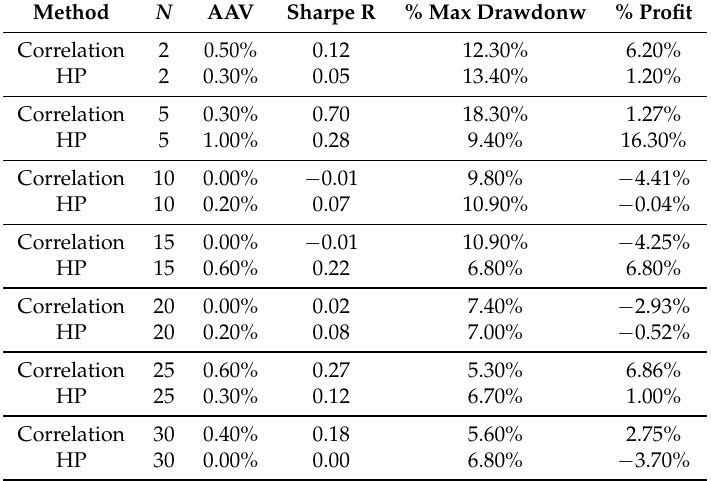
Figure 17. Comparative cumulative log-return of a 15-pair portfolio between HP methods and Pearson’s correlation coefficient, of Dow Jones securities in the period 2000–2018. Table 1. Results obtained for the period 2000–2018, where N is the number of pairs; AAV is the average annualized return; Sharpe R is the Sharpe Ratio and Profit is the profitability for the full period with transaction